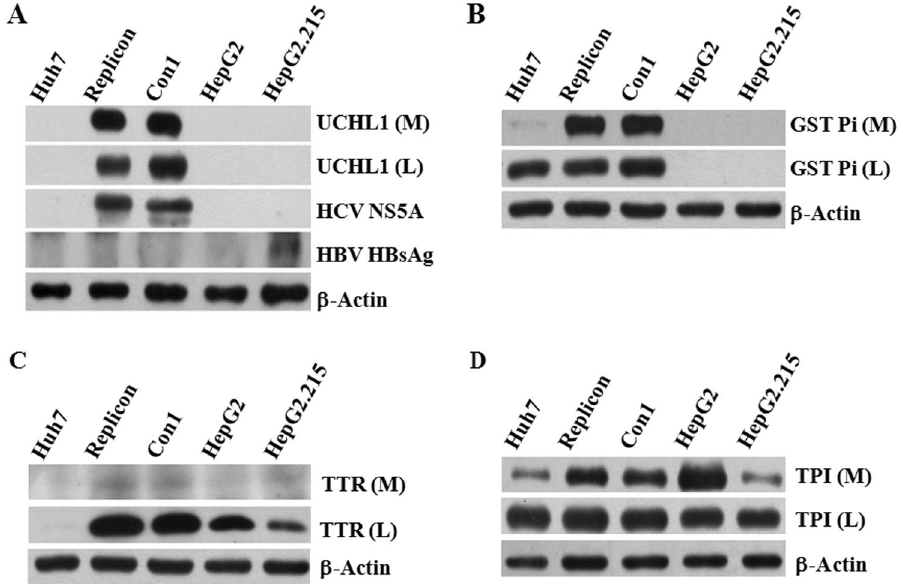
Figure 3. UCHL1 was specifically expressed in HCV replicon cells. ( A–D ) Fifty micrograms of protein from the cultured medium (M) or cell lysate (L) of the indicated cells were analyzed by Western blotting using the antibodies against UCHL1 (panel A), GSTpi (panel B), TTR (panel C) and TPI (panel D), respectively. HCV- NS5A and HBV-HB surface antigen (HBsAg) expression were used to confirm the authenticity of HCV and HBV genome-containing cell lines (panel A). The expression of β -actin in the cell lysates was used as a control for equal protein loading. The full Western blot and the corresponding positions of the molecular weight protein markers are presented in Supplementary Fig.